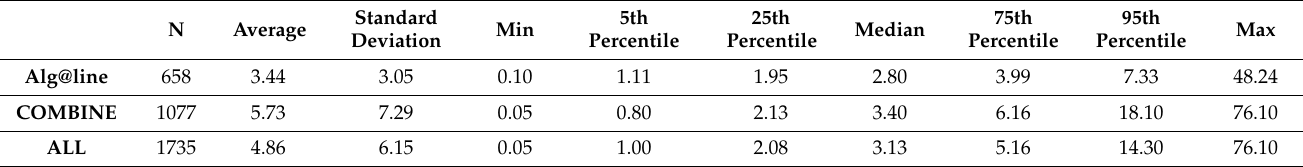
Table 1. Summary statistics for Chl-a in situ measurements in Alg@line transects and COMBINE